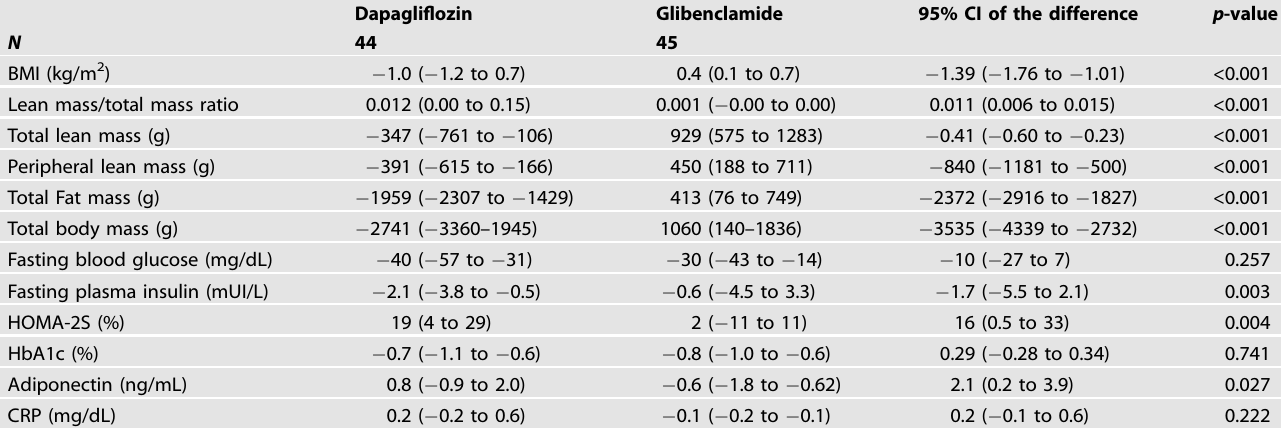
Table 2. Changes in primary and secondary